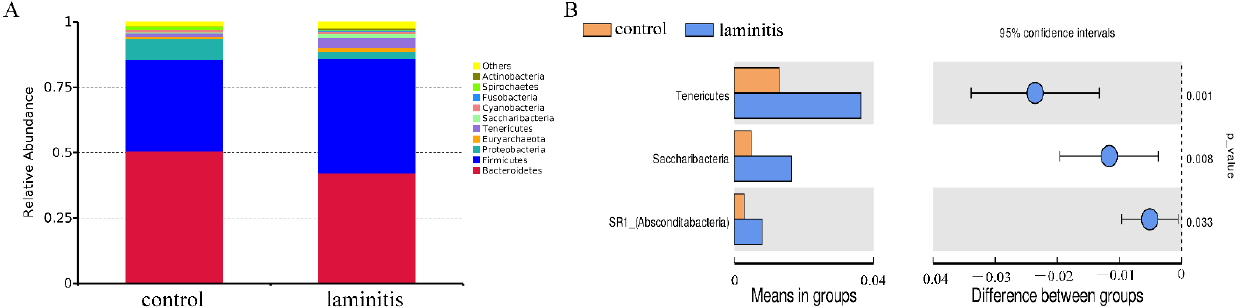
Figure 3. Changes in ruminal bacterial community at the phylum level ( A ) relative abundances of the top 10 phyla of rumen fluid between control and laminitis group cows. Bacteroidetes , Firmicutes , and Proteobacteria were the most abundant phyla in ruminal bacterial community; ( B ) a t -test showed that the relative abundances of Tenericutes , Saccharibacteria , and SR1 were significantly increased in laminitis cows compared to the control group.